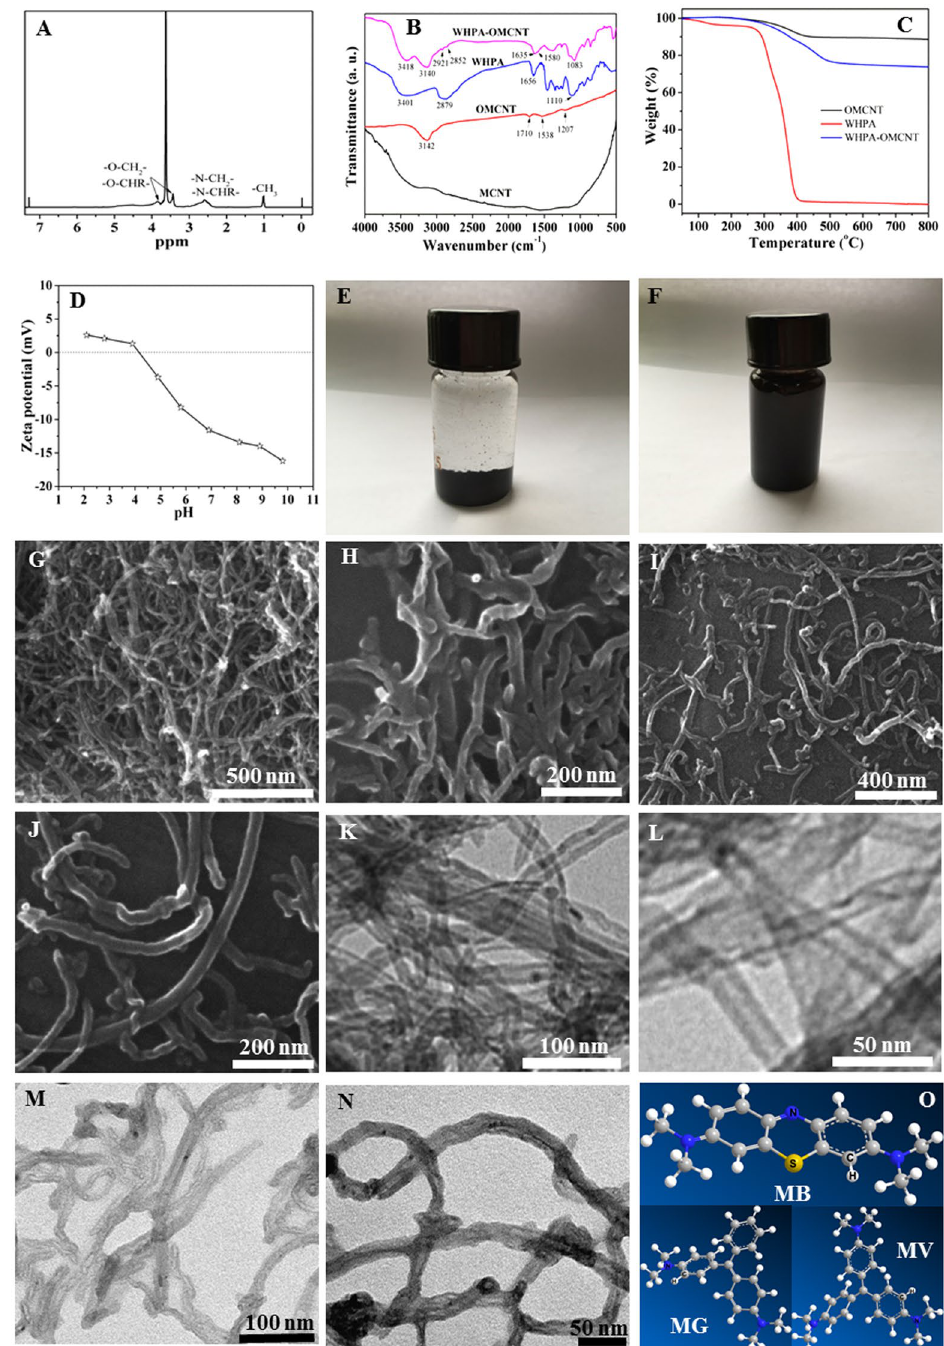
Figure 2. Characterization of as-prepared adsorbent: 1 H NMR spectrum of WHPA in CDCl 3 ( A ); FTIR spectra ( B ) and TGA analysis ( C ) of OMCNT, WHPA and WHPA-OMCNT; Zeta potential of WHPA-OMCNT ( D ); photographs for the dispersion status of OMCNT ( E ) and WHPA-OMCNT ( F ) in water settled for 3 h and two months, respectively; SEM images of OMCNT ( G,H ) and WHPA-OMCNT ( I,J ); TEM images of OMCNT ( K,L ) and WHPA-OMCNT ( M,N ); 3D models of MB, MG and MV molecules ( O